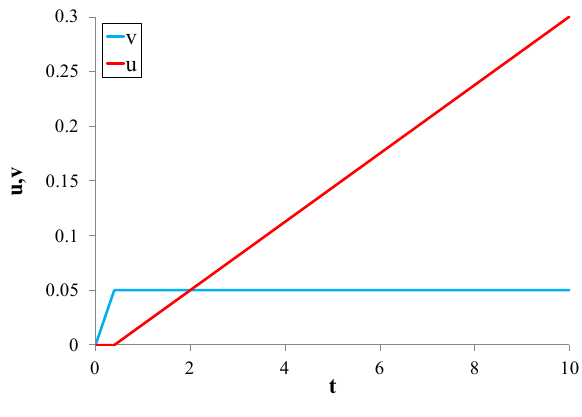
Figure 7: Loading